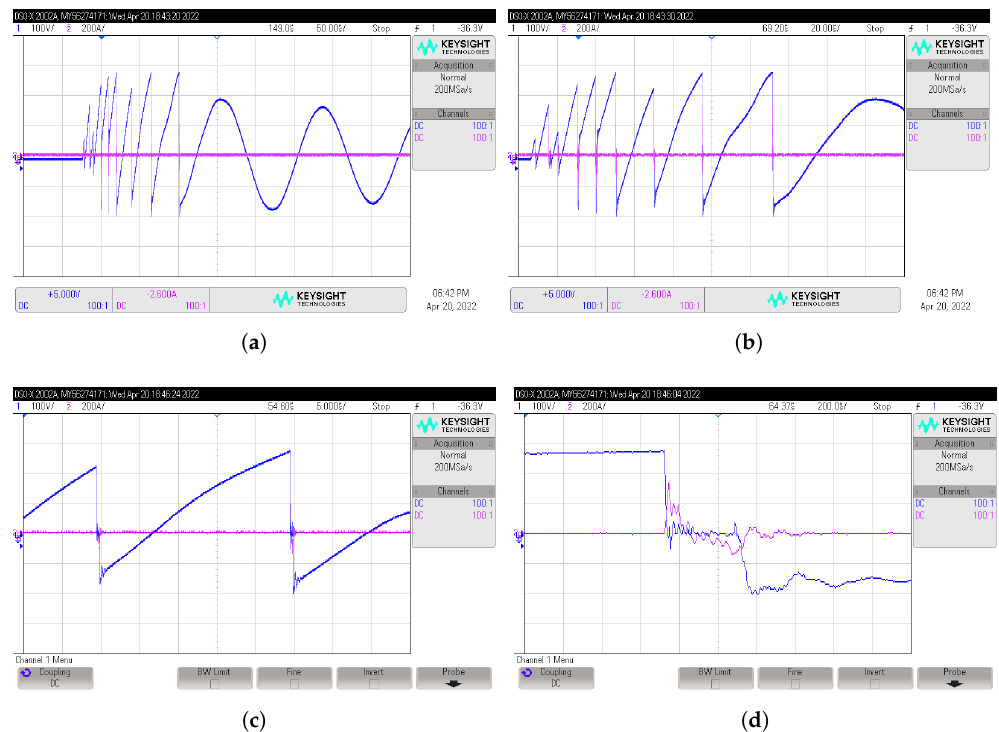
Figure 5. Waveform in details. ( a ) Waveforms of periodic case (parameters: 100 V/div, 200 A/div, 50 us/div). ( b ) Waveforms of disturbances (parameters: 100 V/div, 200 A/div, 20 us/div). ( c ) One cycle of the disturbance (parameters: 100 V/div, 200 A/div, 5 us/div). ( d ) Discharge one cycle of the disturbance (parameters: 100 V/div, 200 A/div, 200